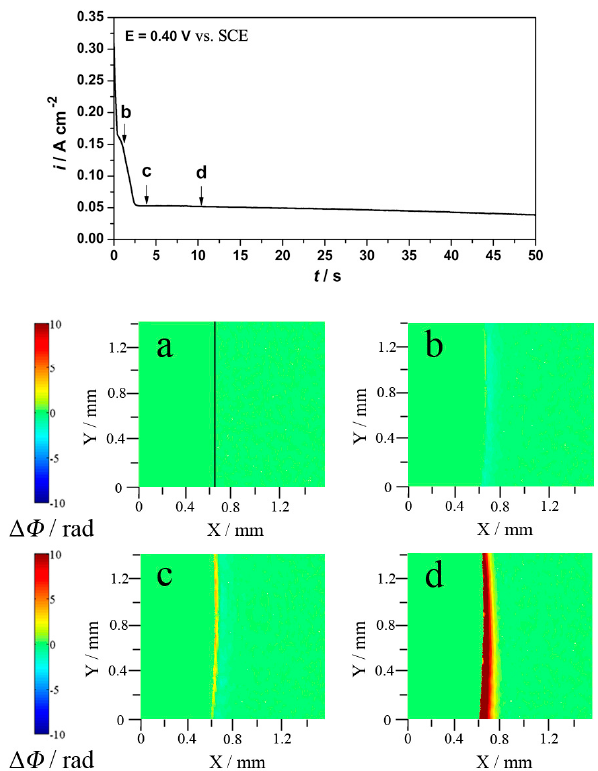
Figure 8. The i - t curve of Cu / NaCl system at 400 mV vs. SCE (Top). ( a ) was obtained at OCP. ( b – d ) are the phase maps corresponding to the points b–d in the curve.